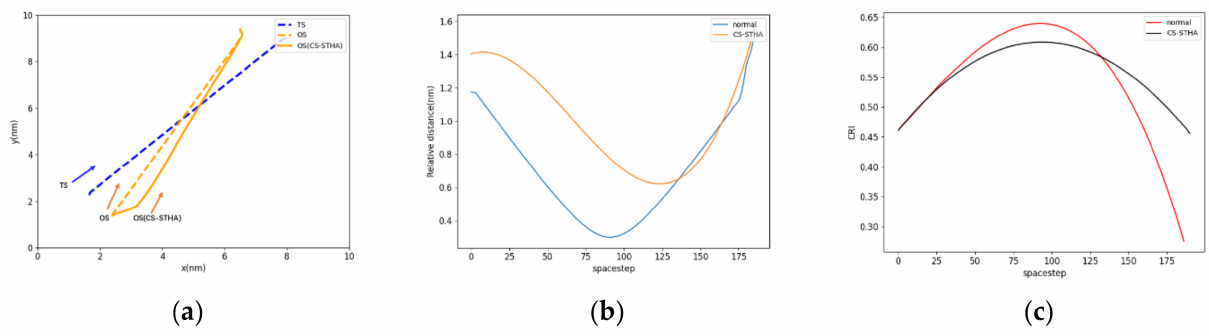
Figure 12. The result of the overtaking encounter between the two ships. ( a ) trajectories; ( b ) relative distance; ( c ) CRI.